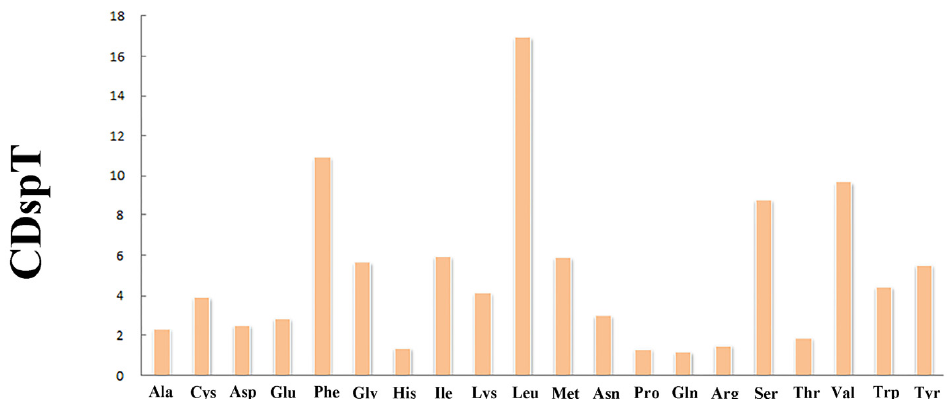
Figure 2. Amino acid compositions of M. virgata mitochondrial genomes.